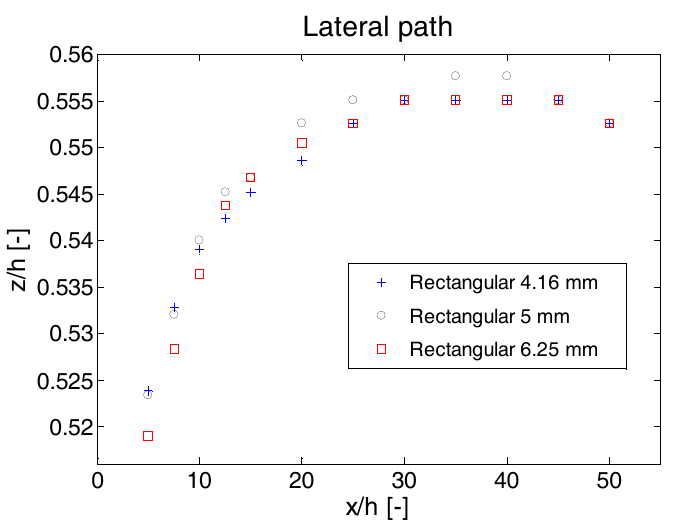
Figure 13. The development of the vortex center in the horizontal direction.